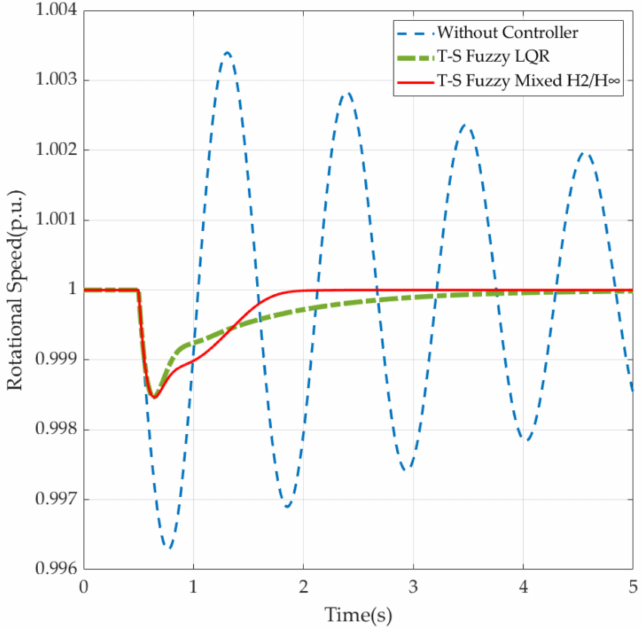
Figure 16. The curve of unit’s rotational speed change during sudden 0.2 (p.u.) load increase.